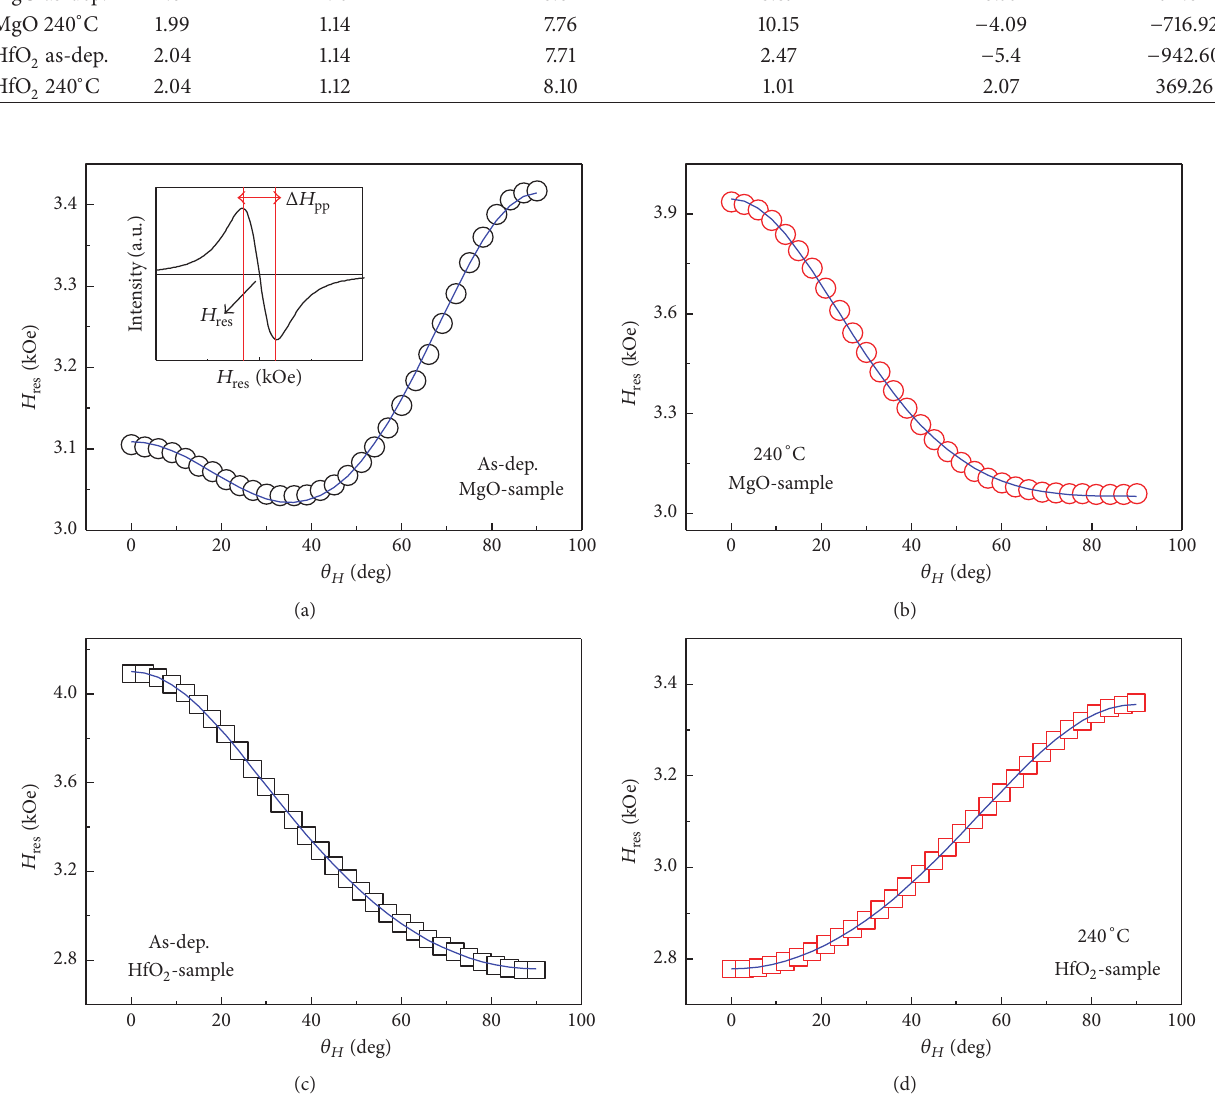
Figure 4: (a)-(b) Out-of-plane angular dependent resonance fields 𝐻 res for sample Ta(0.8)/Co 20 Fe 80 (0.8)/MgO(0.8)/Ta(1.0) (in nm) in the as-deposited and 240 ∘ C annealed states. Hollow circles and solid lines represent experimental data and theoretical fitting of 𝐻 res . Inset: typical FMR differential absorption spectra where the resonance field 𝐻 res and peal-to-peak linewidth Δ𝐻 pp are defined. (c)-(d) Out-of-plane angular dependent resonance fields 𝐻 res for sample Ta(0.8)/Co 20 Fe 80 (0.8)/HfO 2 (0.8)/Ta(1.0) (in nm) in the as-deposited and 240 ∘ C annealed states. Hollow diamonds and solid lines represent experimental data and theoretical fitting of 𝐻 res